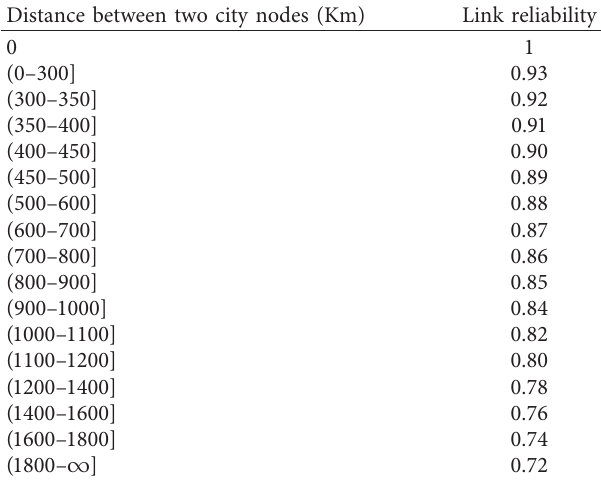
Table 4: Link reliability based on geographical distance. Distance between two city nodes (Km)